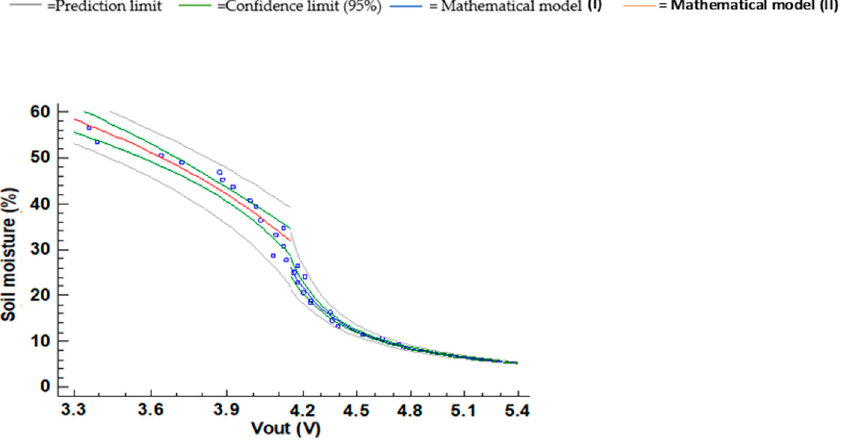
Figure 28. Vout NP2, 500 kHz, two models (II), Equations (28) and (29) as mathematical model I and II, respectively.